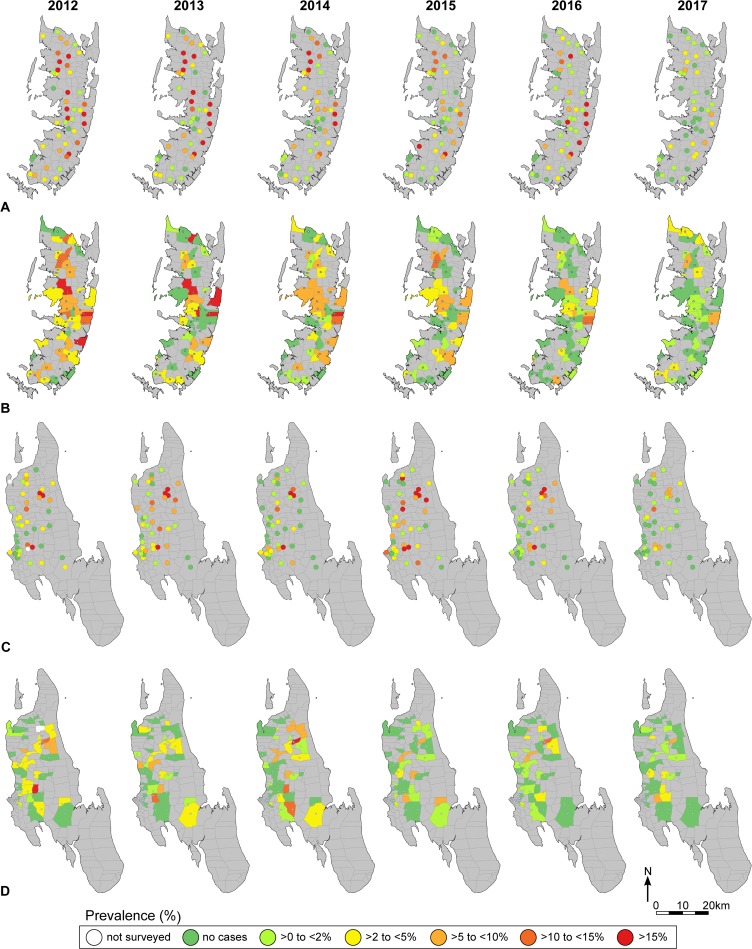
S. haematobium prevalence.Maps showing the annual prevalence in 45 schools/shehias in Pemba and Unguja, respectively, for each of the surveyed population groups. A) 9- to 12-year old children in Pemba; B) 20- to 55-year old adults in Pemba; C) 9- to 12-year old children in Unguja; D) 20- to 55-year old adults in Unguja. Maps were created with QGIS version 2.14.21 using coordinates of schools collected with a handheld Garmin GPSMAP 62sc device (Garmin, Kansas City, USA) and shape files of shehias provided by the Zanzibar Health Management Information System to the Neglected Diseases Program of the Zanzibar Ministry of Health.